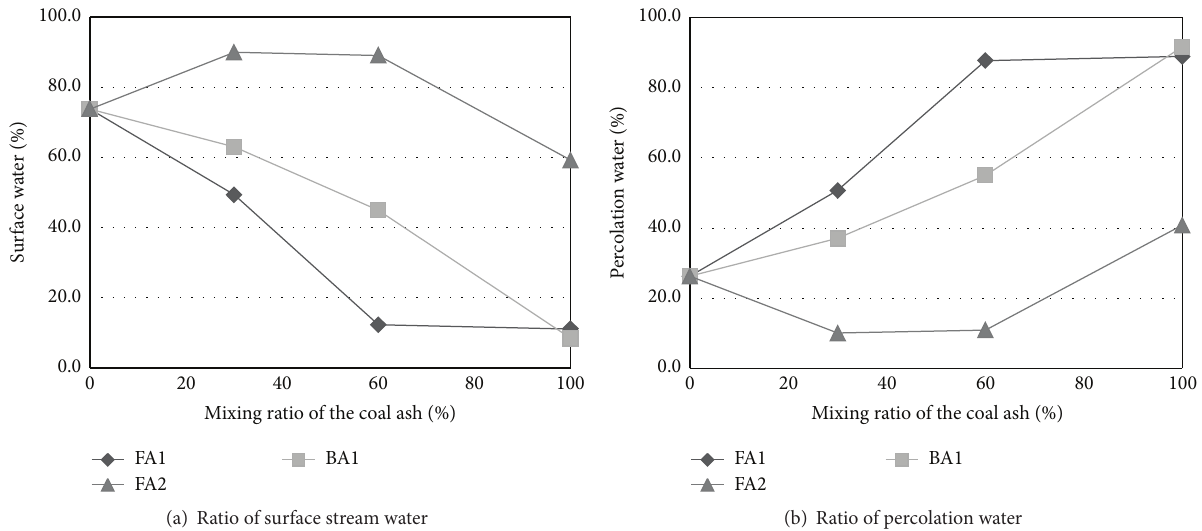
Figure 10: Ratio of each type of water flow in the simulated topsoil mixed with the coal ash at the mixing ratio of 0%, 30%, 60%, and 100% in the artificial rainfall